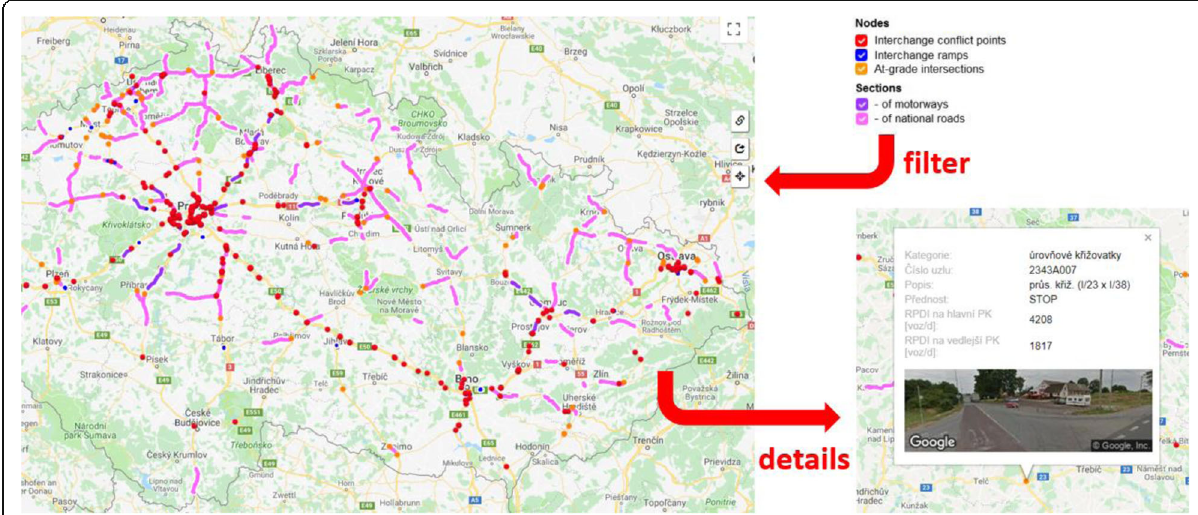
Fig. 2 Illustration of a principle of the developed on-line map with the results of network safety